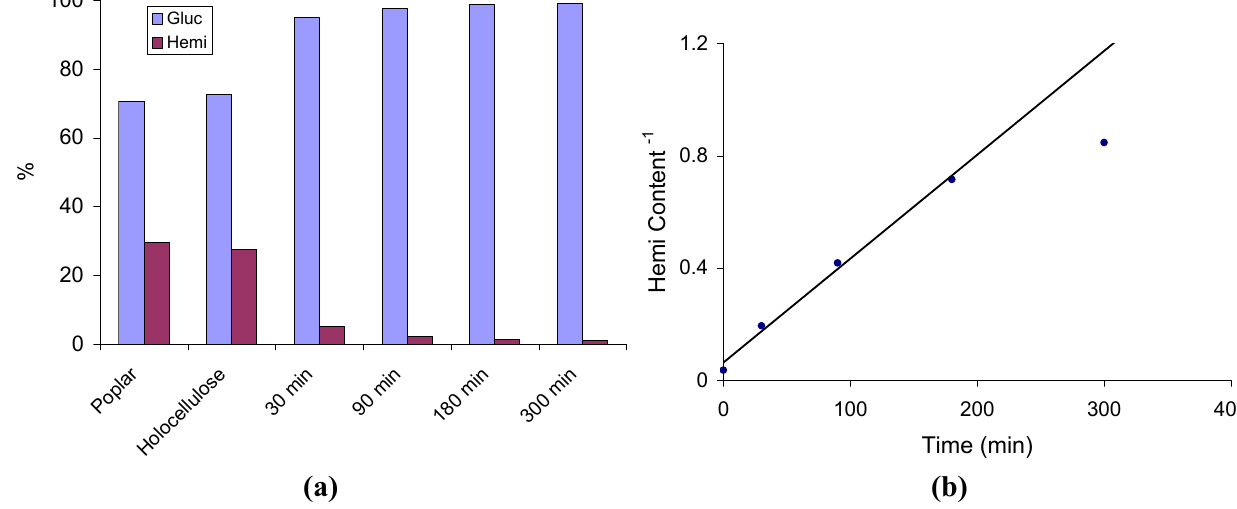
Figure 1. ( a ) Carbohydrate distribution and ( b ) reciprocal of the hemicellulose (Hemi) content for a Populus standard after holocellulose pulping and hemicellulose removal by acid hydrolysis in 2.5 M HCl at various residence